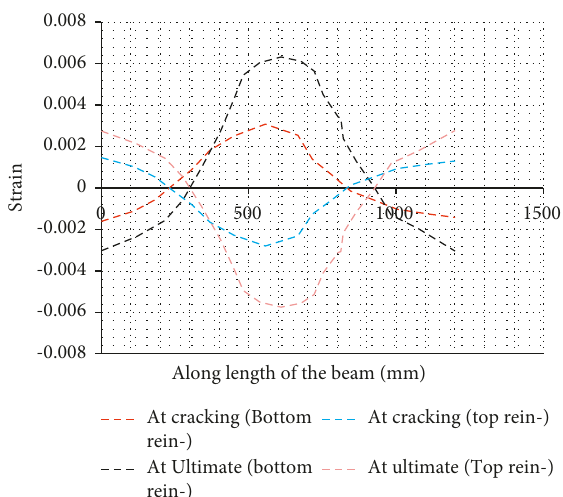
Figure 7: Strain distribution in the bottom and the top longitudinal steel